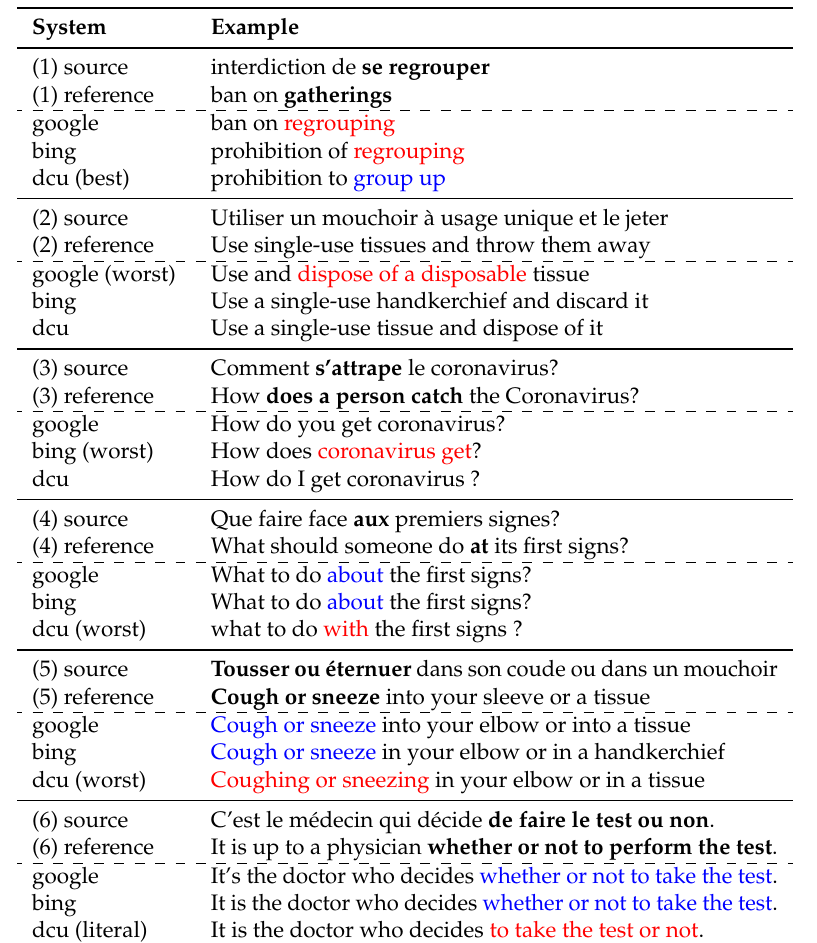
Table 10. Translation examples for